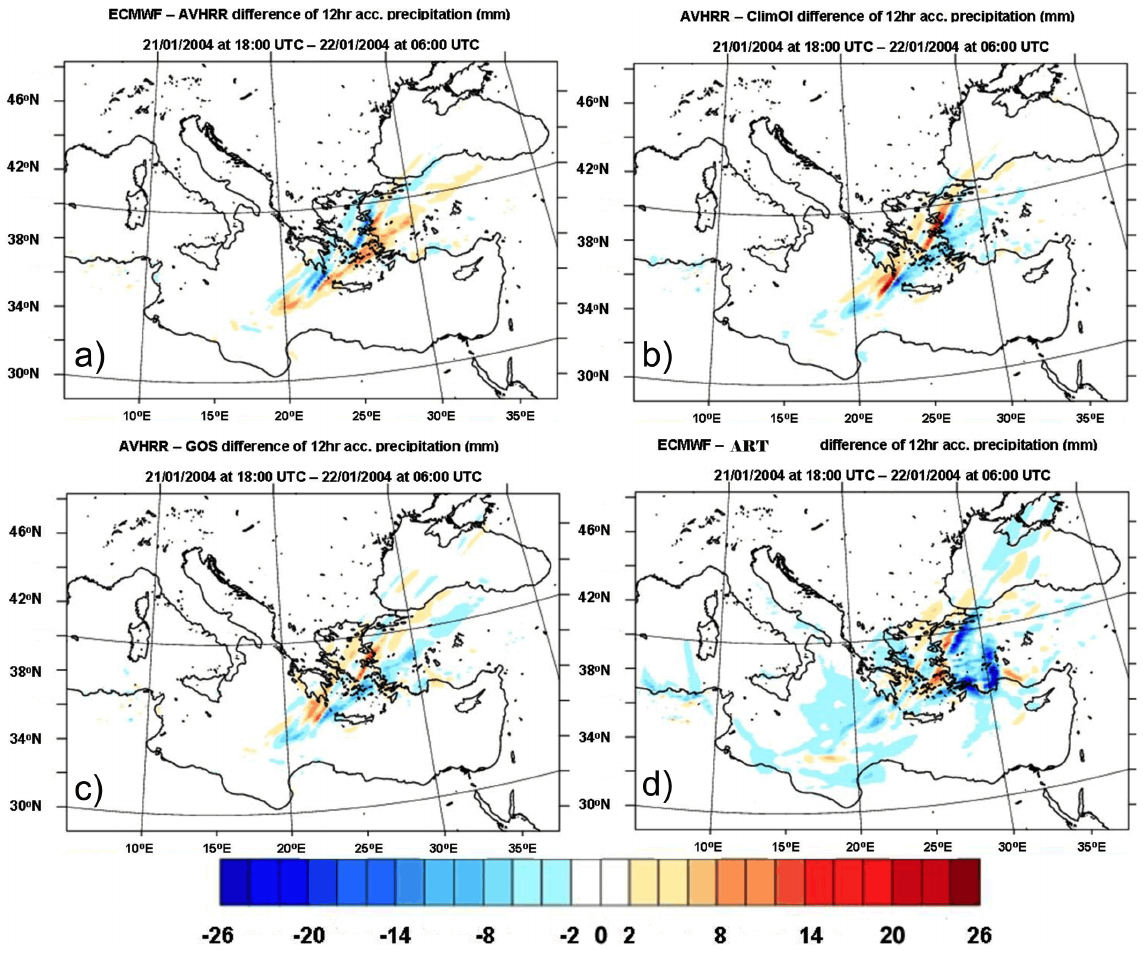
Fig. 6. Maps of difference of the 12-h accumulated precipitation (mm) over Greece between the experiments: (a) ECMWF-SST and AVHRR- SST, (b) AVHRR-SST and ClimOI-SST, (c) AVHRR-SST and GOS-SST and (d) ECMWF-SST and ART-SST for the period 18:00 UTC, 21 January 2004 to 06:00 UTC, 22 January 2004. Values in the range ± 2mm are masked